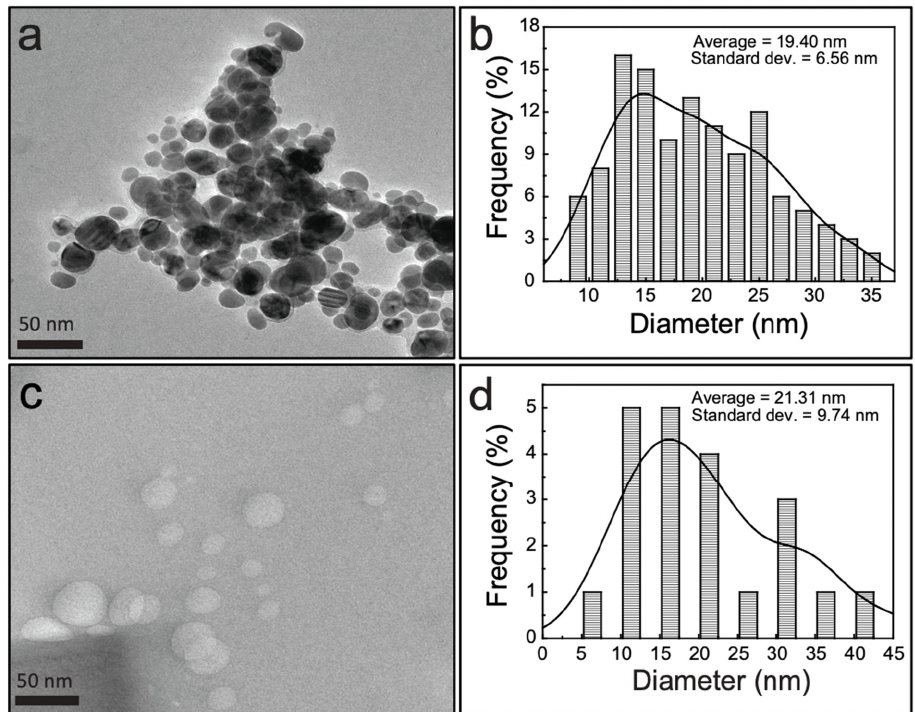
Figure 5. TEM images of ( a ) AgNPs and ( c ) CNSs; histograms of the diameters of ( b ) AgNPs and ( d ) CNSs, as calculated from images ( a ) and ( c ), respectively.